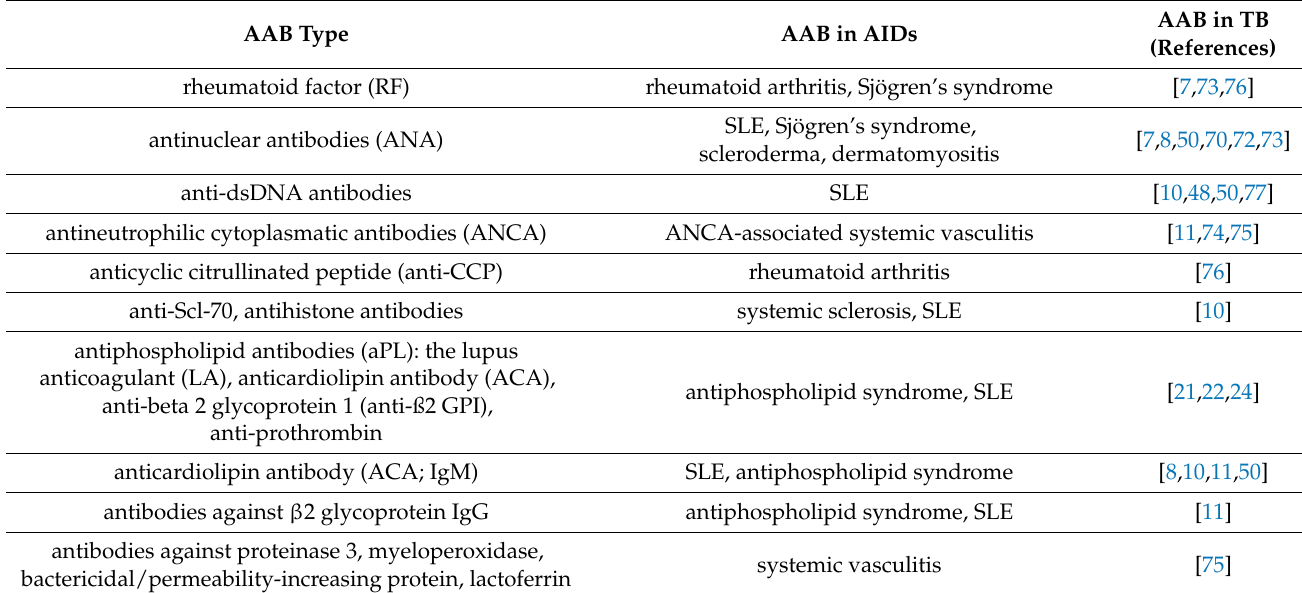
Table 1. The autoantibodies in